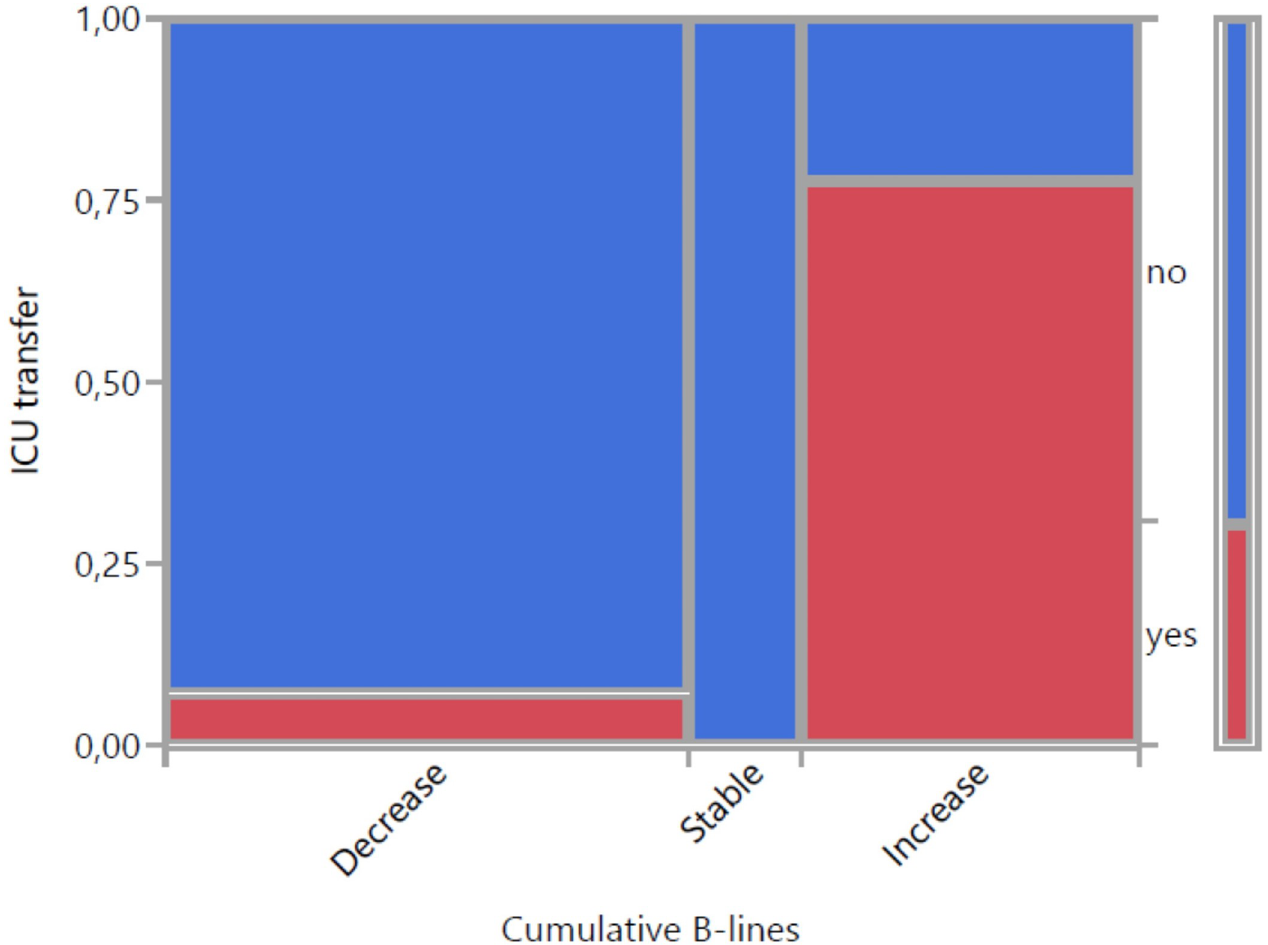
Fig 6. Visualization of change in B-lines with 3 categories and ICU transfer (mosaic plot).